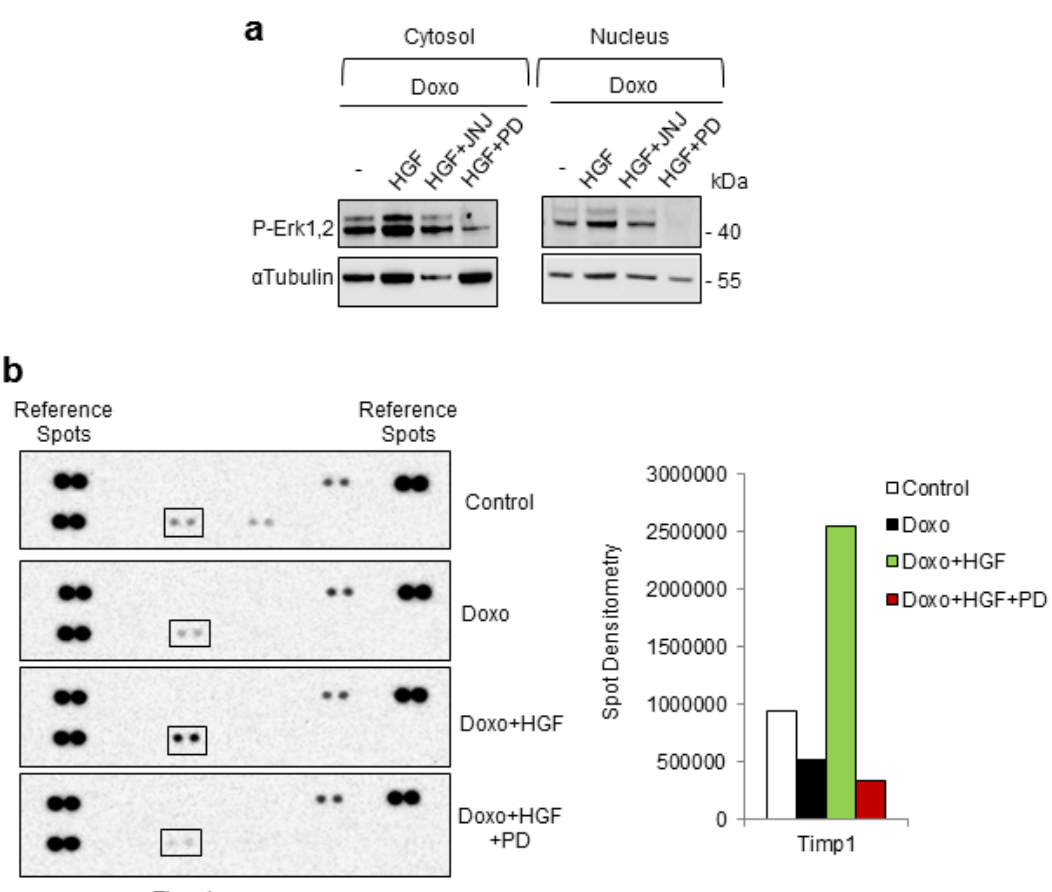
Figure 3. Cytokine profiles induced by HGF-Met-Erk1,2 preconditioning against Doxo damage. H9c2 cells were untreated (control) or treated with Doxo (25 µ M), Doxo + HGF (0.5 nM), Doxo + HGF + PD (PD98059, 1 µ M) ( a , b ) and Doxo + HGF + JNJ ((JNJ38877605, 500 nM) ( a ). Cells were treated with the inhibitors (PD and JNJ) for 4 h and exposed to Doxo in the last hour. For cell treatments, see Figure 1a. ( a ) P-Erk1,2 protein levels were detected in cytosol and nuclear fractions. α tubulin was used as the loading control. ( b ) Representative images (left) and densitometric analysis (right) of protein samples that were probed with the rat cytokine antibody array, that allowed analyzing 29 cytokines simultaneously. Data are representative results of three independent experimental